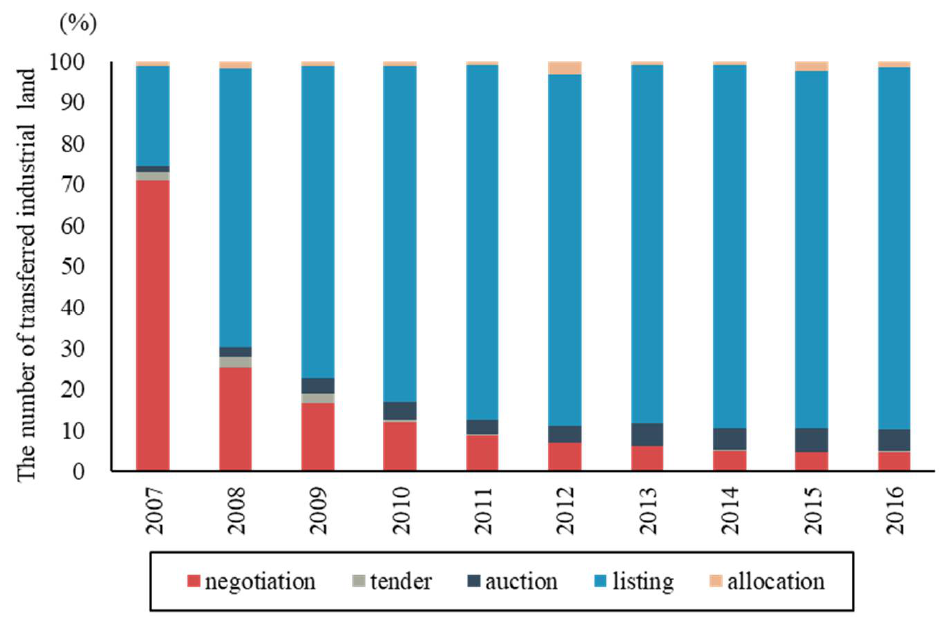
Figure 1. Amount of industrial land transferred by different modes. 3 Data source: Chinese land market network (http://www.landchina.com/ accessed on 30 July 2020).